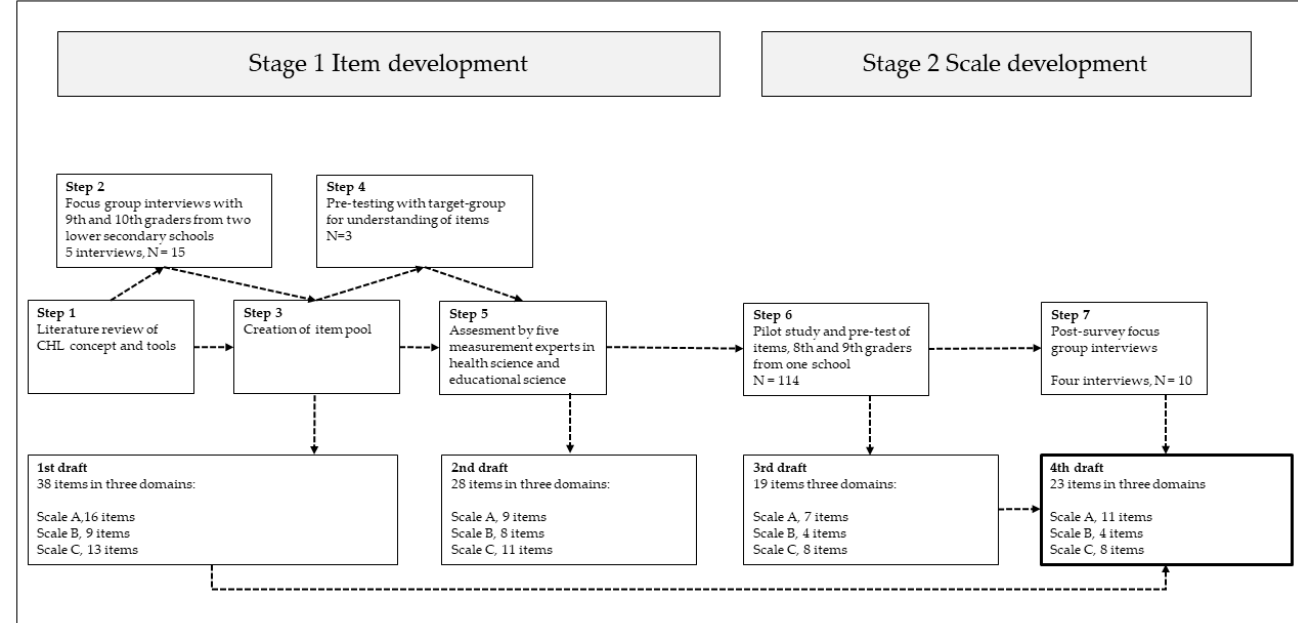
Figure 1. Stages of the study. Scale A: Critical Information Appraisal; Scale B: Awareness of Social Determinants of Health; Scale C: Citizenship for Health and Well-Being in the School Context